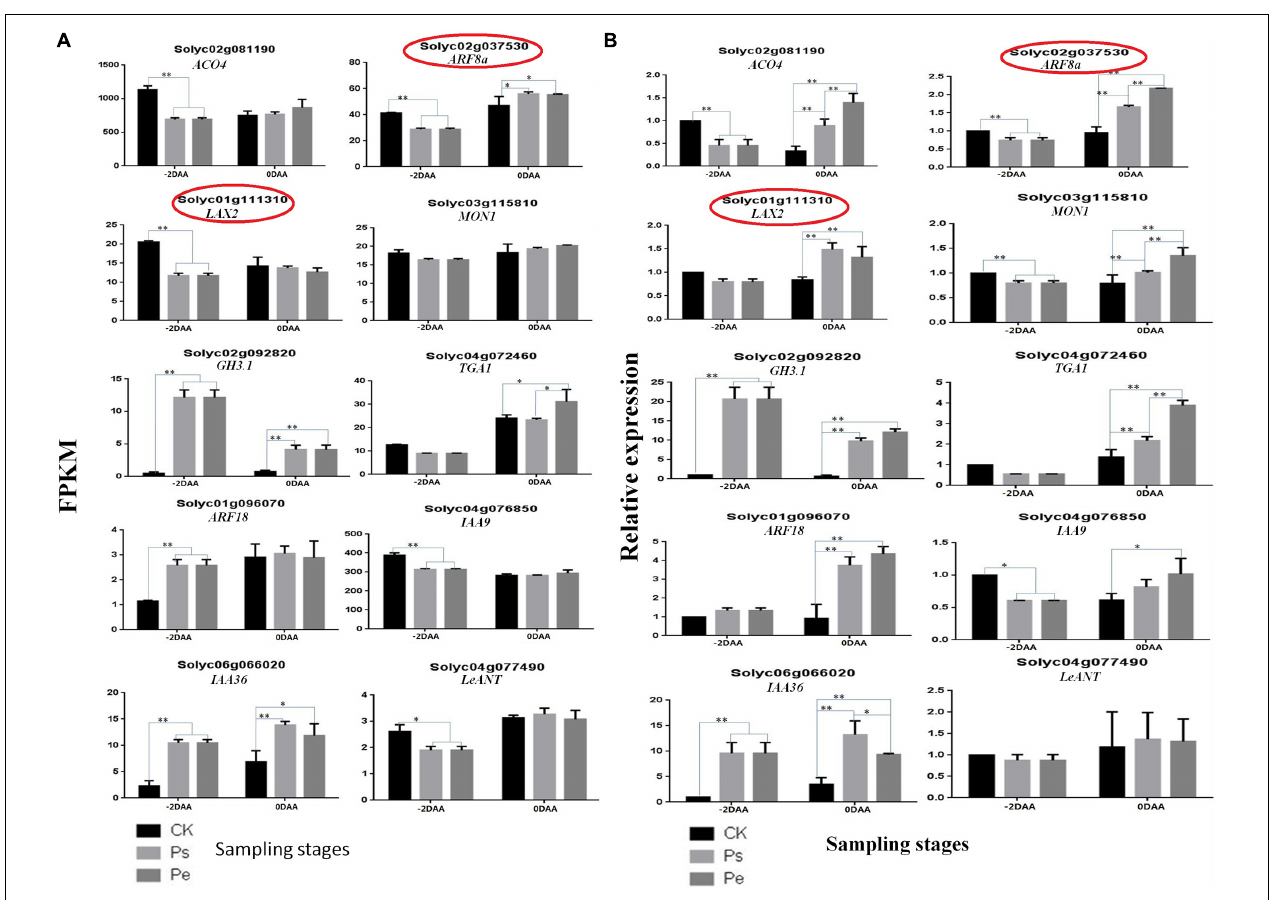
FIGURE 5 | Validation of RNA-seq data by RT-PCR. (A) Expression levels of 10 DEGs were detected by RT-PCR, normalized based on the expression of the internal control gene, at − 2 DAA (days after anthesis) and 0 DAA. (B) Corresponding genes expression were detected by RNA-seq based on the FPKM method (Padj < 0.05). The genes denoted by ◦ had a different trend at 0 DAA between RT-PCR and RNA-seq. The bars represent standard errors of three replicates ( n = 3). ∗ P < 0.01 , ∗∗ P < 0.001 by two-way